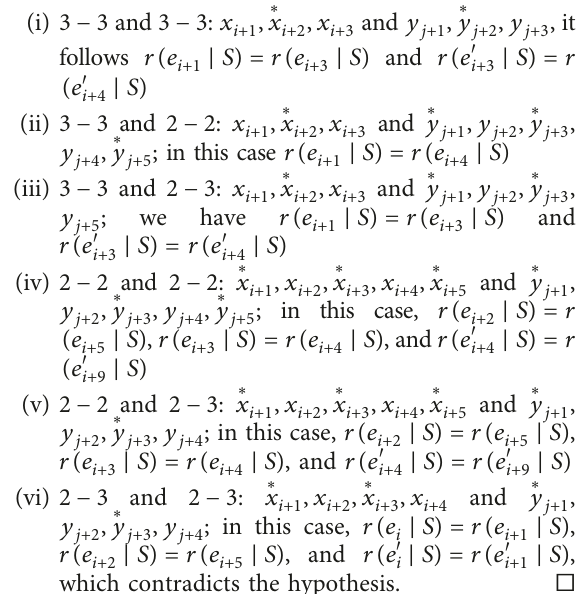
2 n ). (a) J 8 . (b). J 10